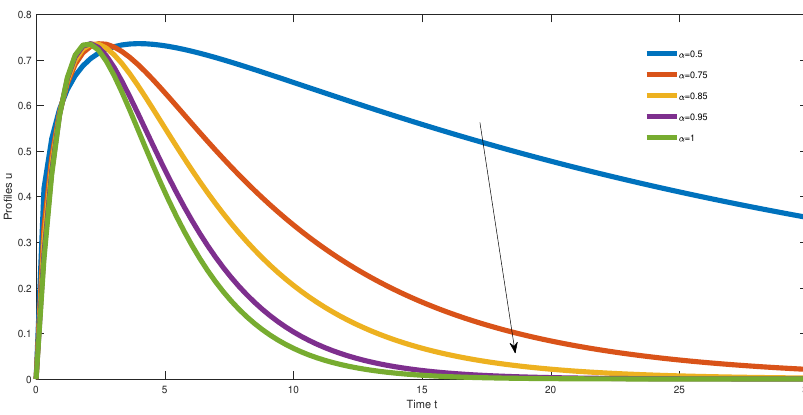
Figure 1. Profiles with different values of the fractional